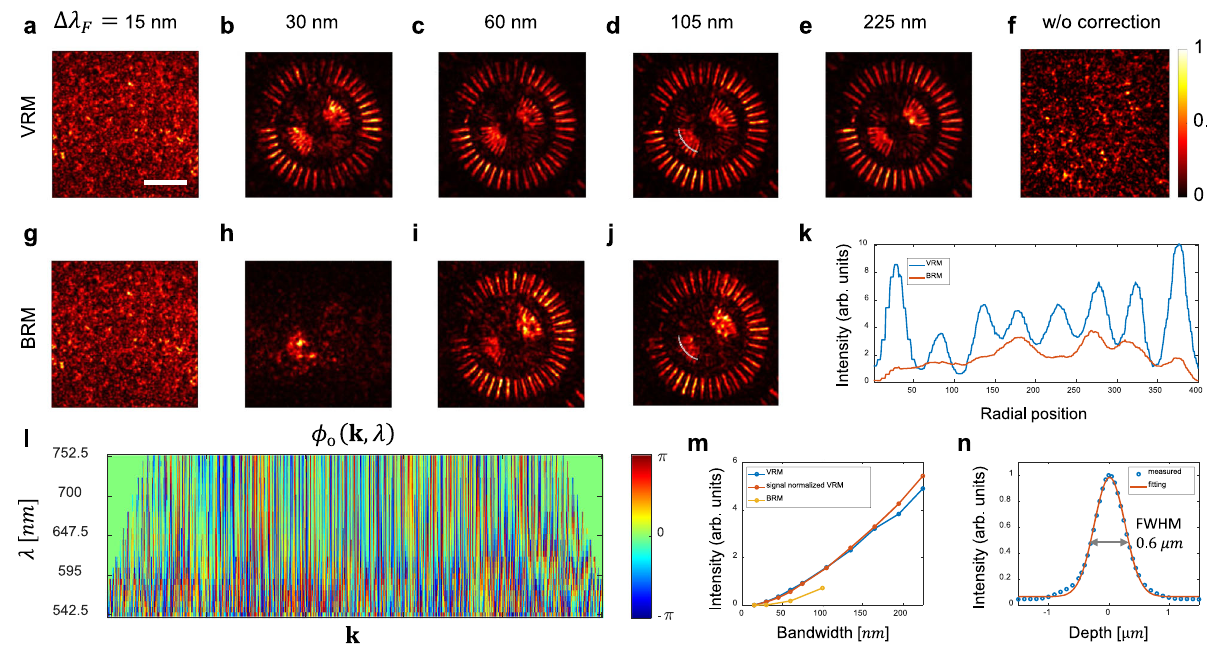
Fig. 4 | Correction of spectro-angular dispersion for optimal volumetric reso- lution. a – e ReconstructedVRM (Volumetric Re fl ectionMatrix)images forspectral bandwidth coverage Δ λ F of 15, 30, 60, 105, and 225nm after spectro-angular dis- persion correction, respectively. Scale bar, 5 μ m . f Reconstructed VRM images for nm without dispersion correction. g – j Reconstructed images in experi- Δ λ F =225 ments with broadband source whose Δ λ F is the same as in a – d , respectively. Therefore, spectral dispersion could not be corrected. Color bar, normalized